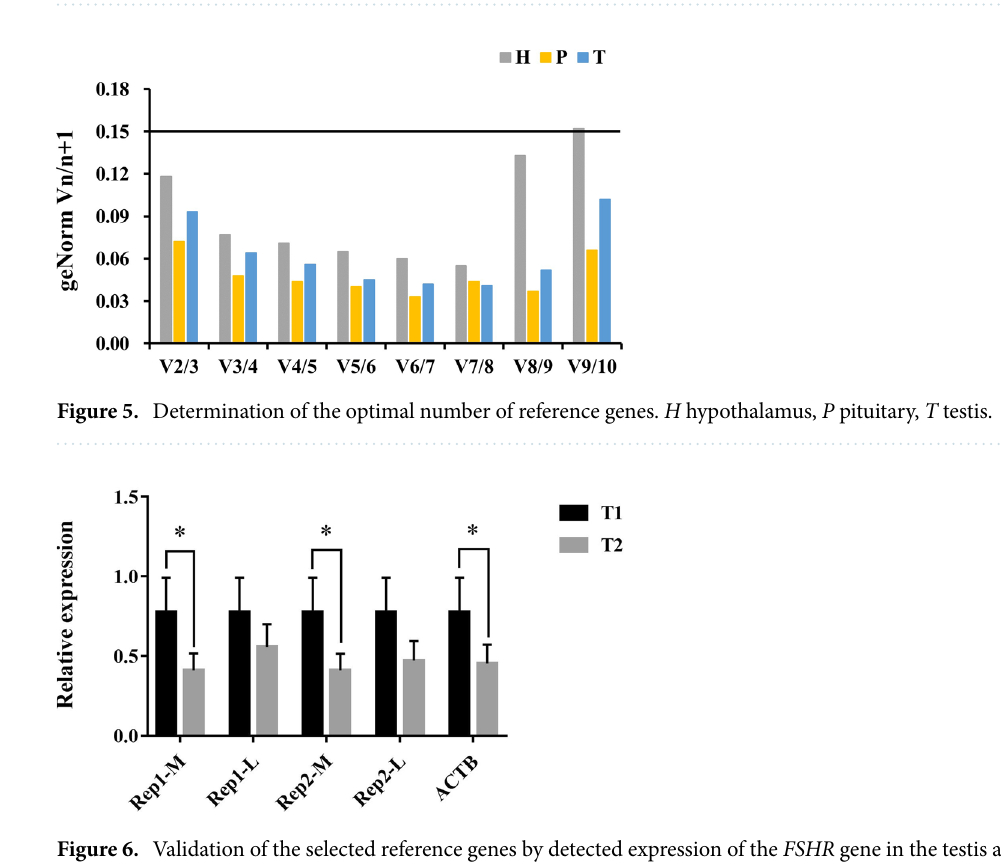
Figure 4. Venn diagrams of the top five internal reference genes derived from four software analyses of the entire reproductive axis.